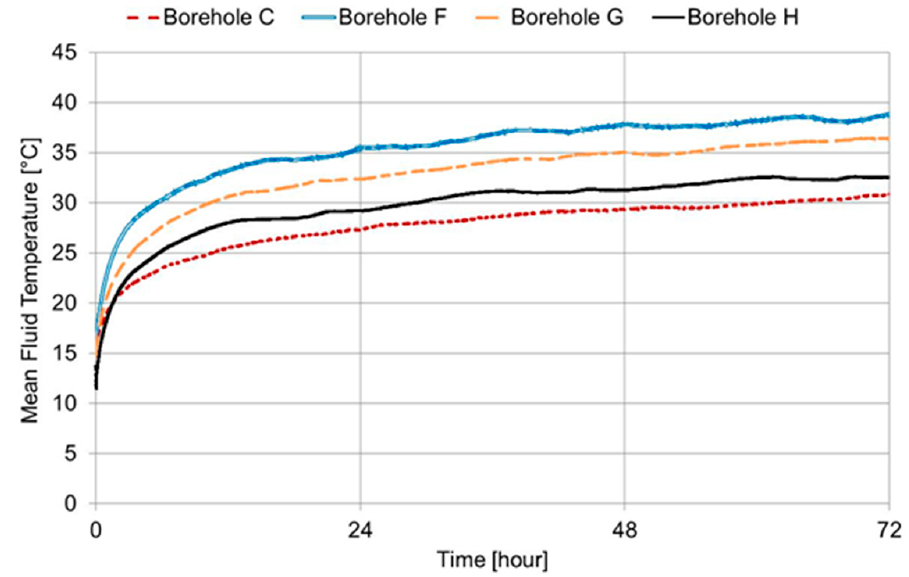
Figure 7. Comparison of the mean fluid temperature of the 50 m long borehole heat exchangers.